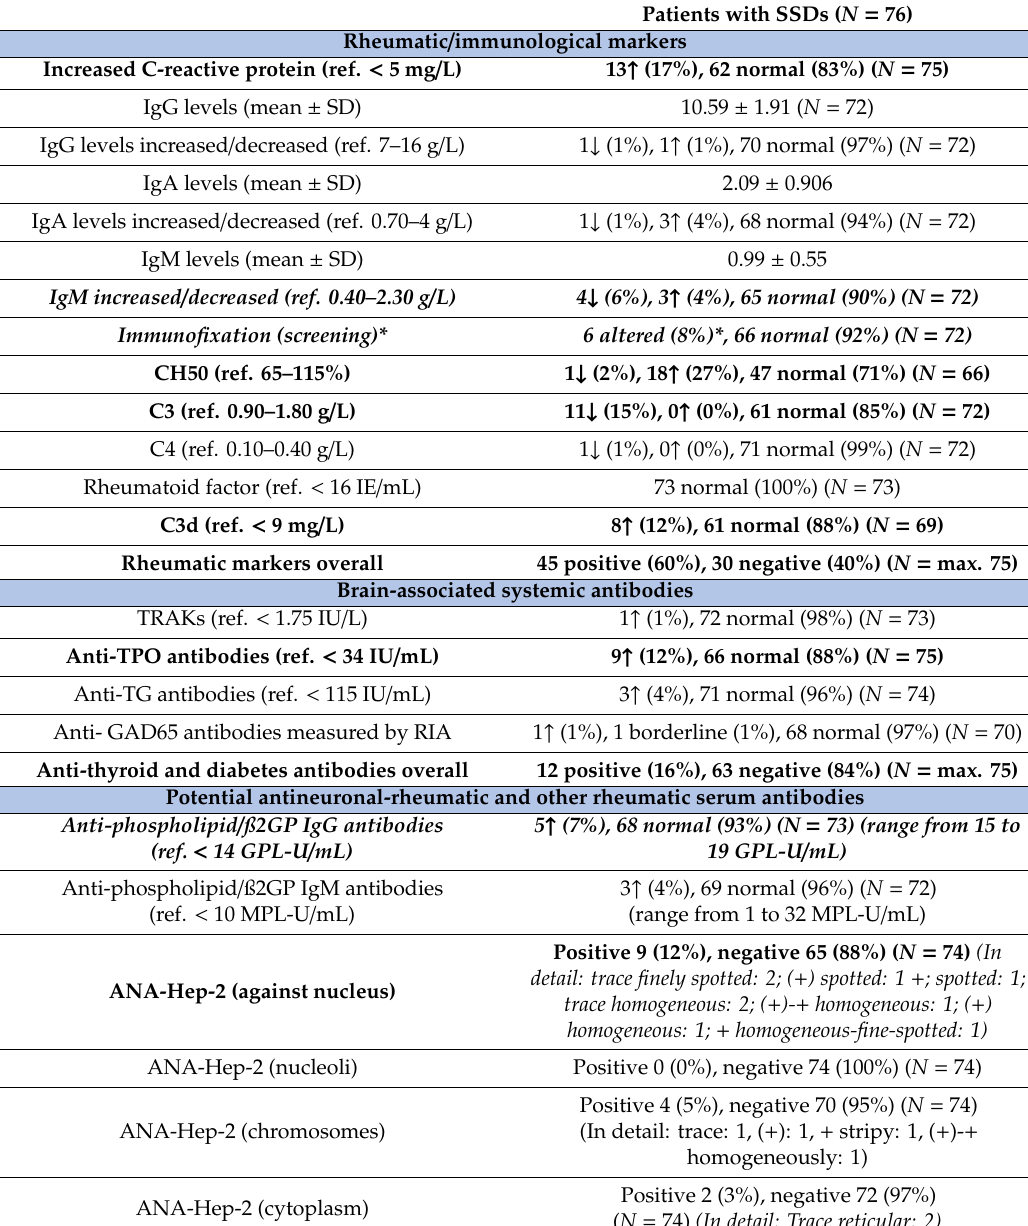
Table 6. Immunological findings in serum of patients with schizophrenia spectrum disorders (SSDs). Values with alterations in > 10% are marked in bold, parameters with changes in > 5% are written in bold and italics. * Abnormal findings of the immune fixation in detail: two patients with polyclonal IgA propagation, one with polyclonal IgG propagation, two with polyclonal IgM propagation, one trace evidence of a monoclonal gammopathy of the type IgG